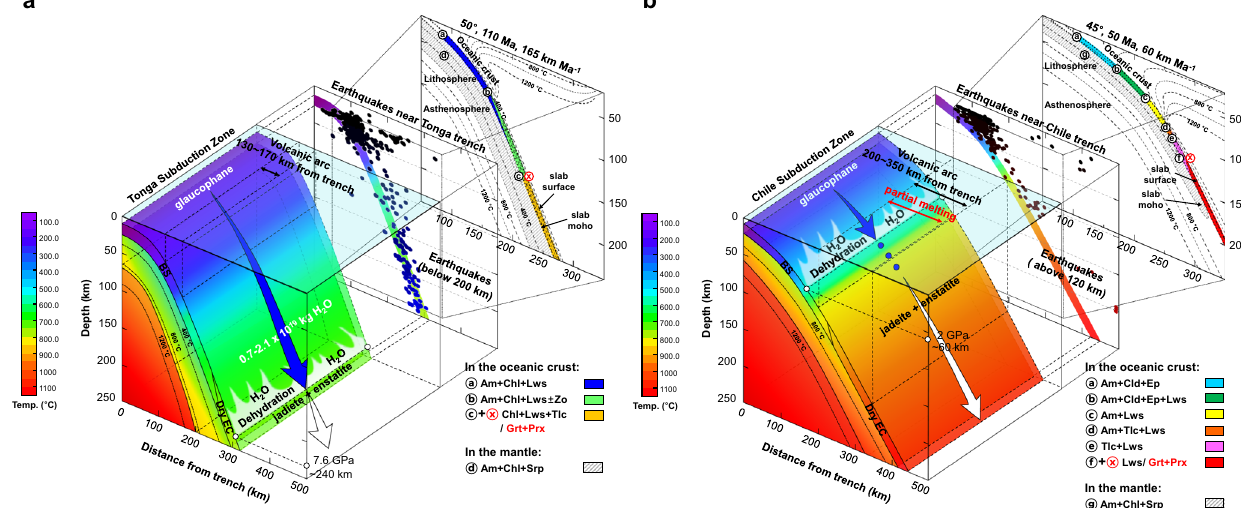
Fig. 4 Subduction models of glaucophane (amphibole) in the contemporary subduction settings. Subducting slab models representing a the Tonga (cold slabs) and b the Chile (warm slabs). The geometry and temperature pro fi les were adopted using the information available from the International Seismological Center (ISC-EHB) 67 – 69 and the thermal models by Syracuse et al. 19 . Glaucophane remains stable along the cold subduction zone down to ca. 240 km depth (blue arrow), whereas it dehydrates and decomposes into jadeite and enstatite along the warm subduction zone between 50 and 100 km depths (white arrow). Based on experiments on a natural blueschist rock, the onset depth of dehydration breakdown is estimated to be ~60 km depth. In the middle 2D projection layer, the earthquake frequencies are shown as fi lled circles using the data from the ISC-EHB. In the upper 2D projection layer, subducting hydrous minerals from Hacker et al. 70 and Magni et al. 71 are shown in colors on each thermal model (slab dip, slab age, and convergence rate of 50°, 110 Ma, 165 km Ma − 1 for the cold slab and 45°, 50 Ma, 60 °C km − 1 for the warm slab). Phase abbreviations: blueschist (BS), eclogite (EC), amphibole (Am), chlorite (Chl), chloritoid (Cld), lawsonite (Lws), epidote (Ep), zoisite (Zo), talc (Tlc), serpentine (Srp), garnet (Grt), and pyroxene